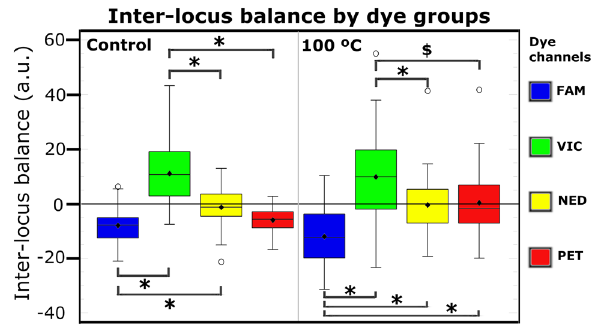
Figure 3. Inter-locus balance in arbitrary units (a.u.) is depicted by dye group (FAM, VIC, NED and PET) and temperature (control − 21 °C and 100 °C). Significant differences: *p < 0.01, $ p < 0.05 (Created using R Core Team, 2013 with package ggplot2) 38 .